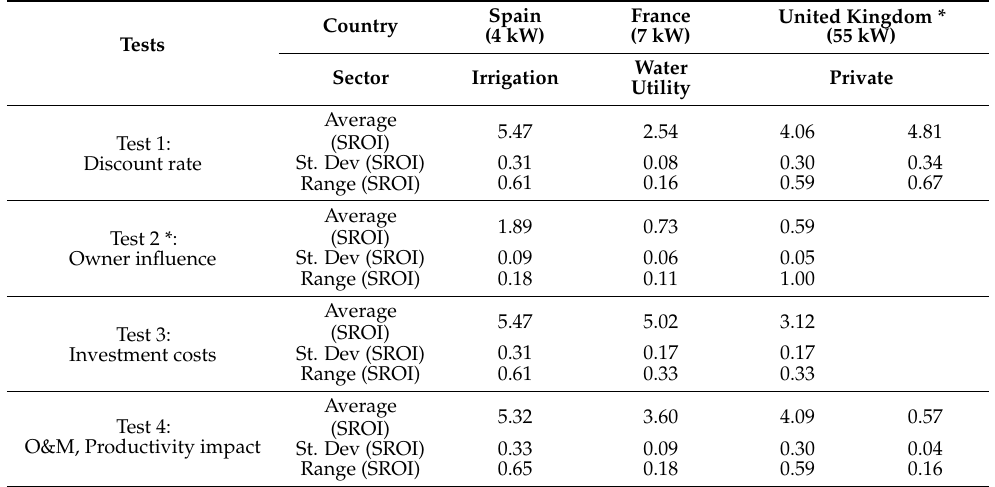
Table 10. Comparison of sensitivity tests.